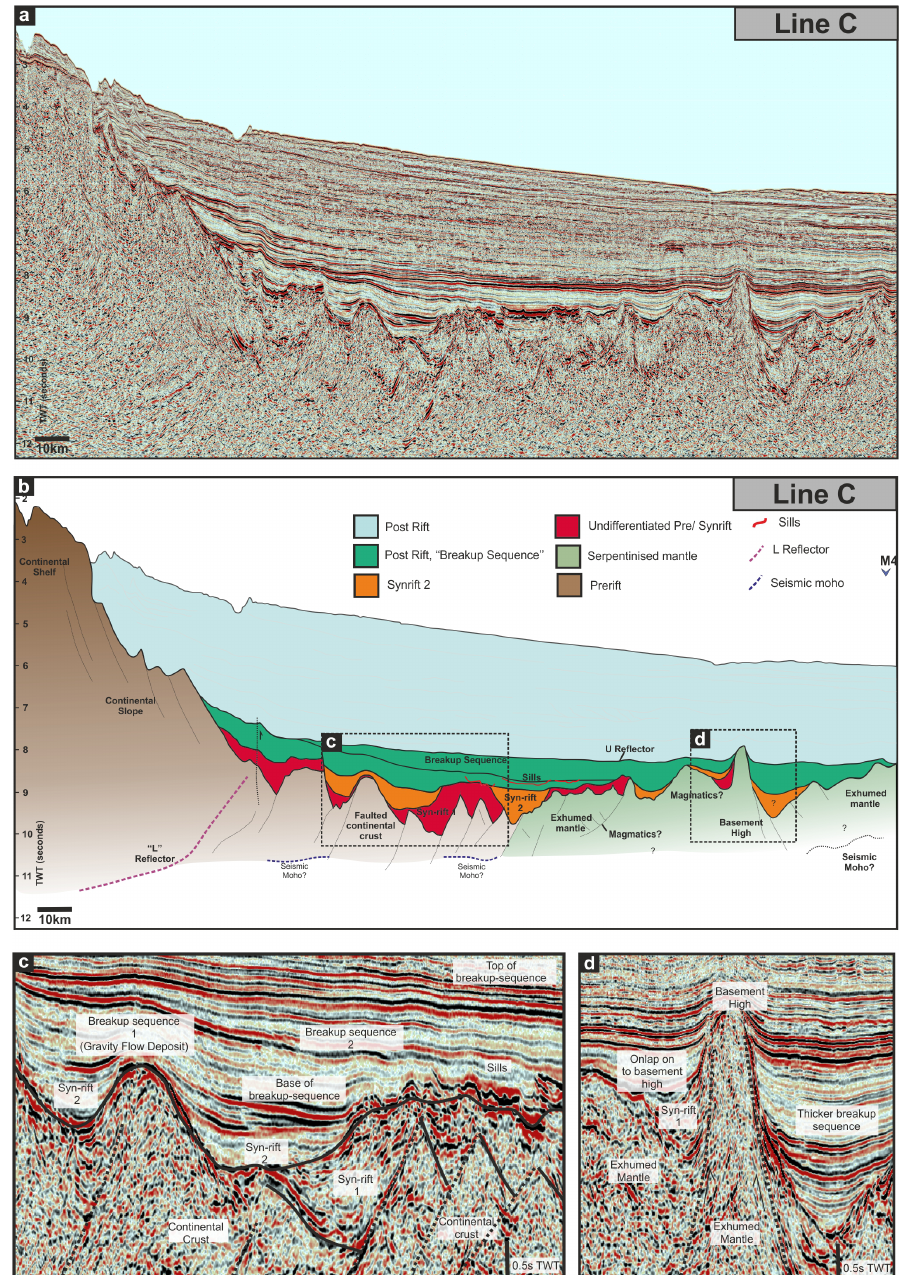
Figure 7. (a–b) Un-interpreted and interpreted seismic reflection profile (“Line C”) from the northern Southern Newfoundland Basin. Inter- pretation shows the basement structure and sedimentary units. (c) Continental crust thinned by small normal faults. (d) Possible serpentinite diapir within the zone of exhumed mantle. All data courtesy of